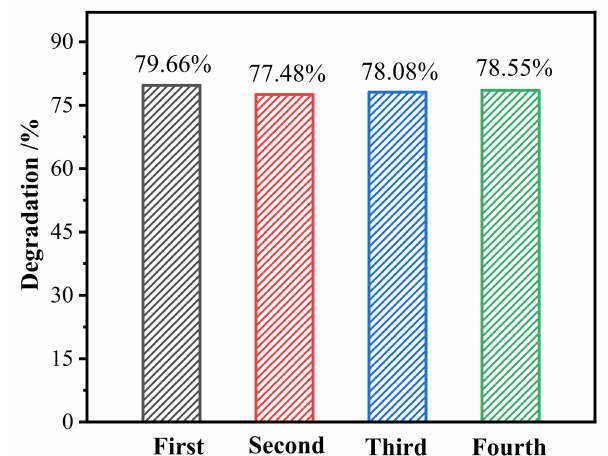
Figure 6. Activity of recycling test of TCN-T 550 for photocatalytic degradation of